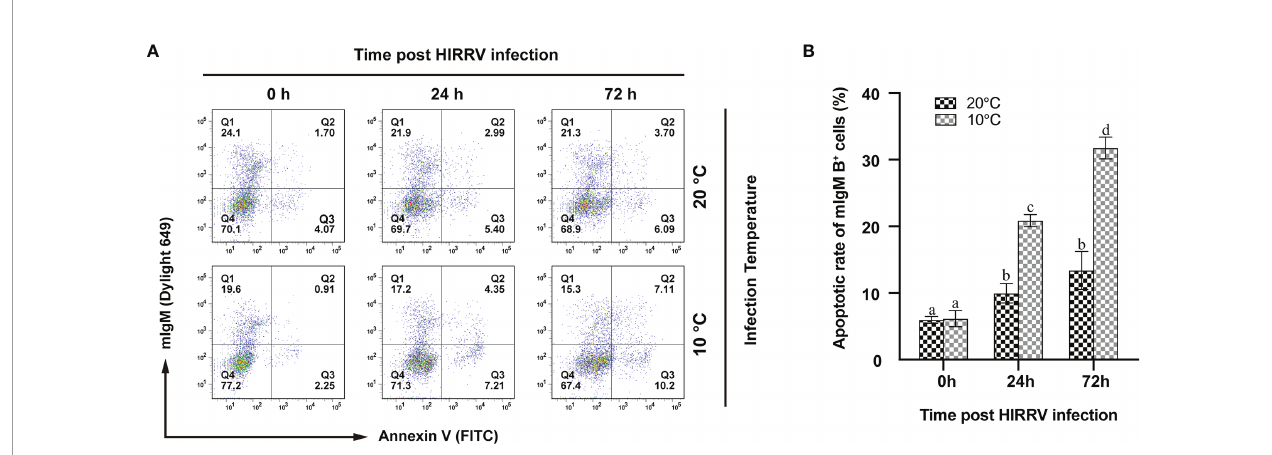
FIGURE 7 | The changes of apoptotic lymphocytes post HIRRV infection by fl ow cytometry. (A) The fl uorescence dot plots represent apoptotic and/or mIgM + B lymphocytes sampled at 0, 24, 72 hpi at 10 and 20°C, respectively. (B) Apoptotic rates of mIgM + B lymphocytes. The results were presented as the means ± SEM of three individuals, different letters above the error bars indicate signi fi cant differences ( p <